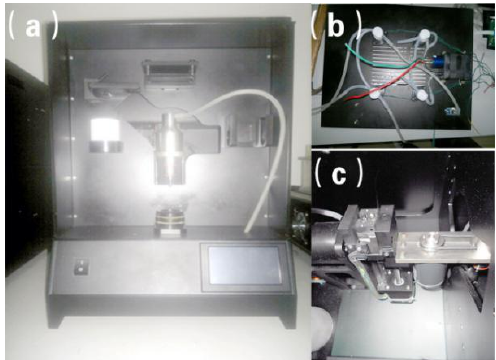
Figure 10. Developed liquid base thin layer cell making machine. ( a ) the front side of working substrate; ( b ) pressure control system; ( c ) the physical map of polar coordinate robot arm and LCD interface.